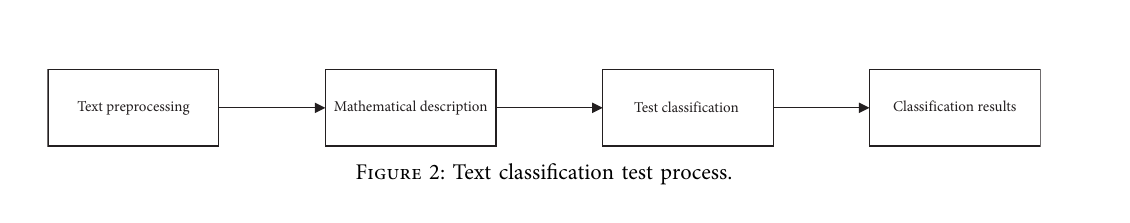
Figure 1: Text classification training process.